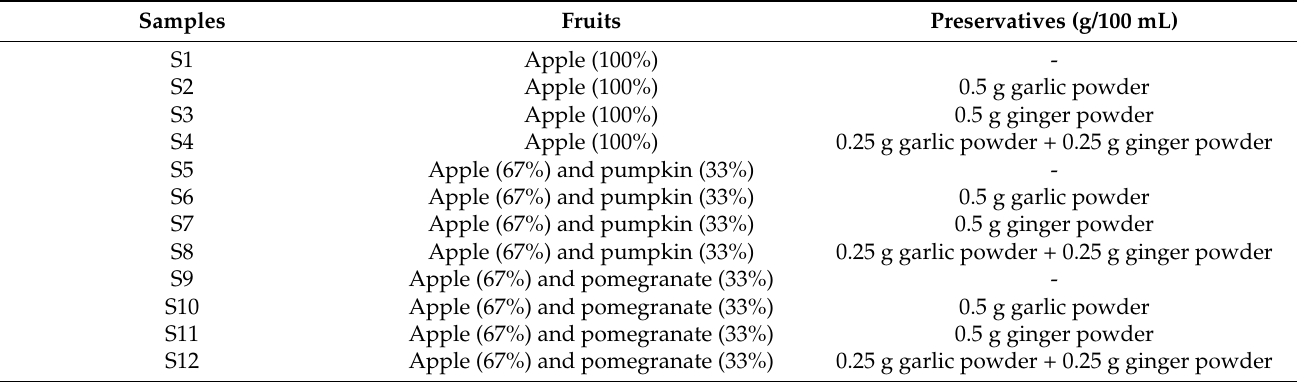
Figure 1. Flow diagram of processing operations for fruit juice production. Table 1. Formulation of analyzed juice assortments.